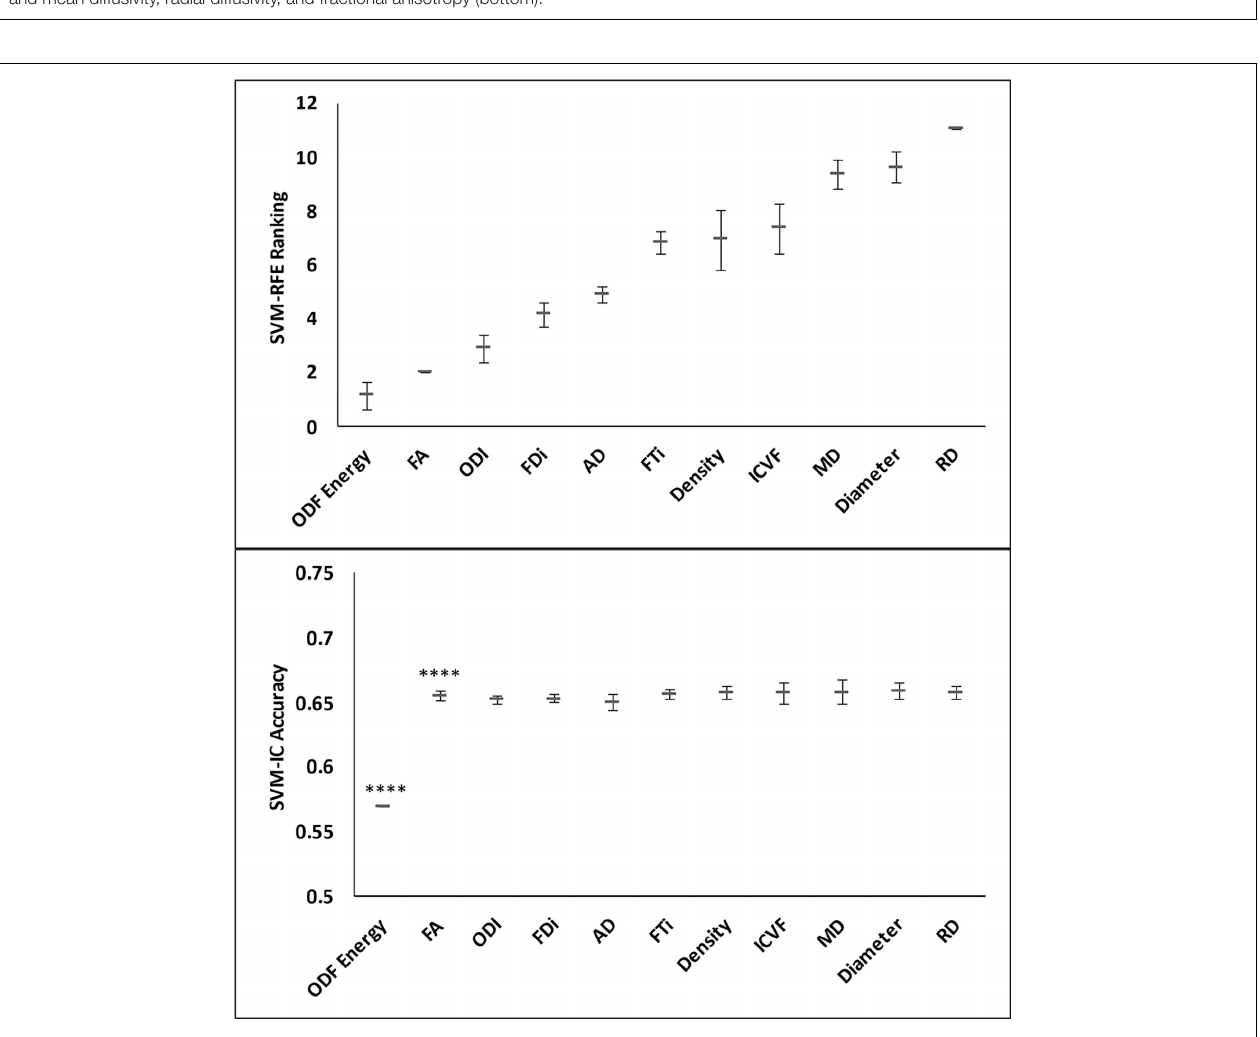
FIGURE 5 | Feature ranks and classification accuracy in lesion-NAWM analysis. Top panel: The mean (standard deviation) rankings of the 11 diffusion features based on the linear recursive feature elimination (RFE) algorithm in SVM. Bottom panel: Accuracy of the classification models (SVM-IC) obtained by adding features one at a time, starting from the highest to the lowest rankings. The stars indicate features that contribute to significant improvement in classification accuracy ( ∗∗∗∗ p < 0.0001).